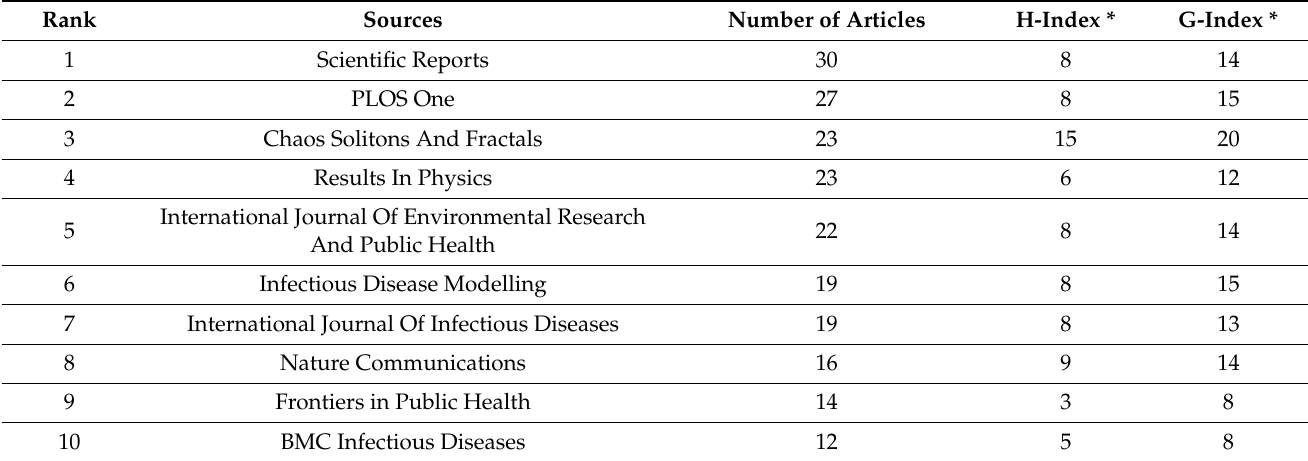
Table 3. Most Relevant Sources (sorted by number of